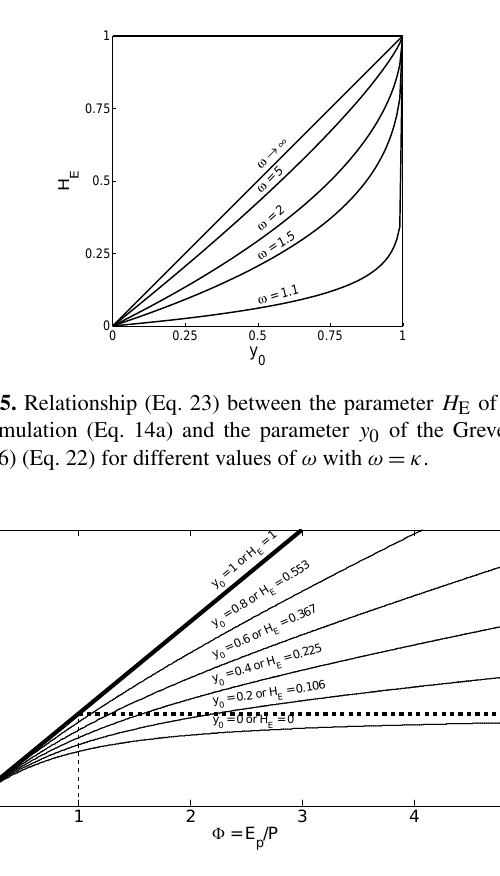
Figure 6. Example showing the similarity of the ML formulation Eq. (14a) and the equation of Greve et al. (2016) Eq. (22) (with ω = κ = 2) for different values of y 0 ; the corresponding values of H E are calculated using Eq.